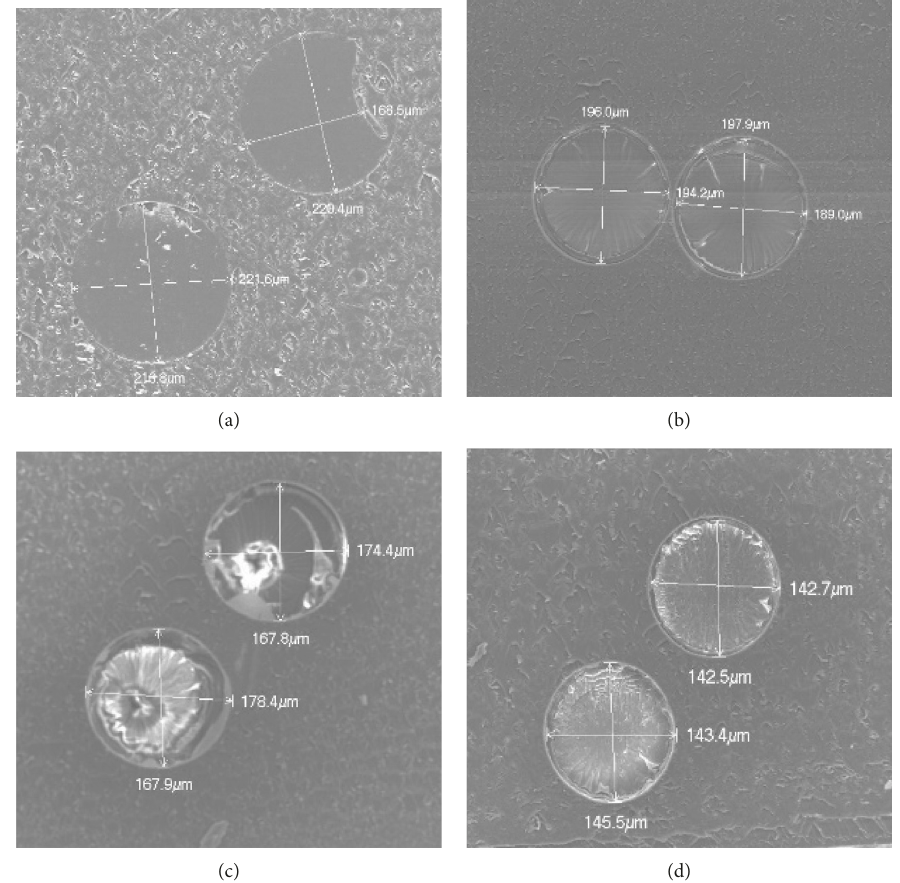
Figure 14: Chemical clad removal using acetone with different immersion times. (a) 30 minutes. (b) 1 hour. (c) 2 hours. (d) 3 hours.